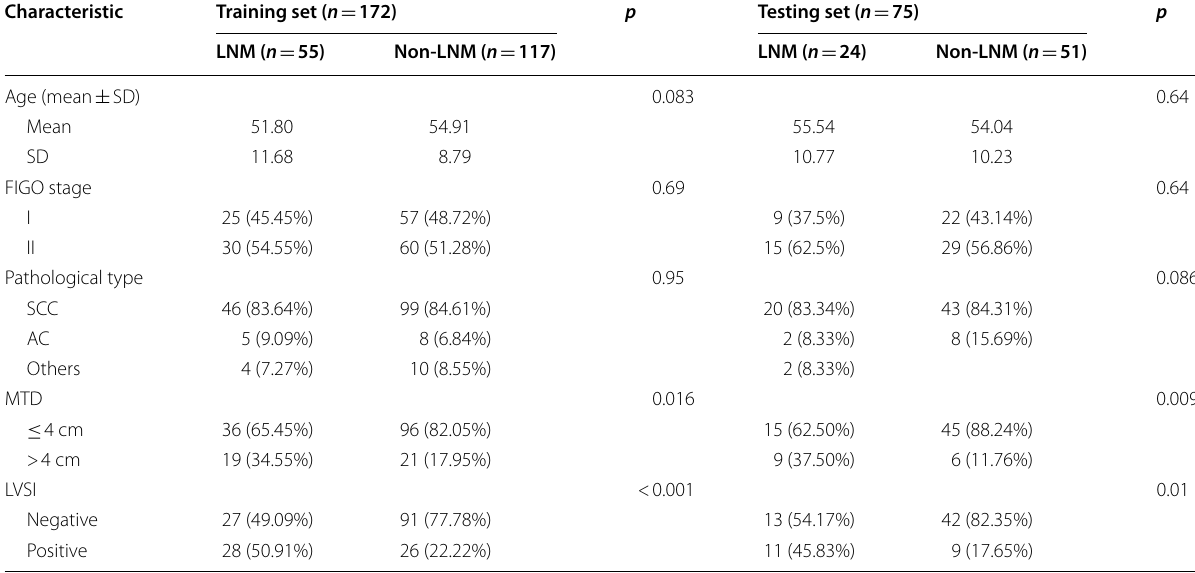
LNM: lymph node metastasis; Non-LNM: without lymph node metastasis; SD: standard deviation; FIGO: International Federation of Gynecology and Obstetrics; MTD: maximum tumor diameter; SCC: Squamous cell carcinoma; AC: Adenocarcinoma; LVSI: lymph-vascular space invasion